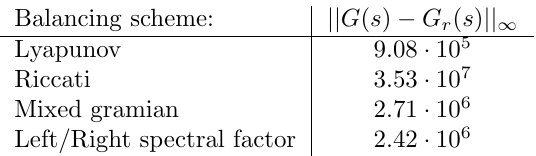
Table 3: || · || ∞ -error between original and reduced or- der system of order n = 10 and n =